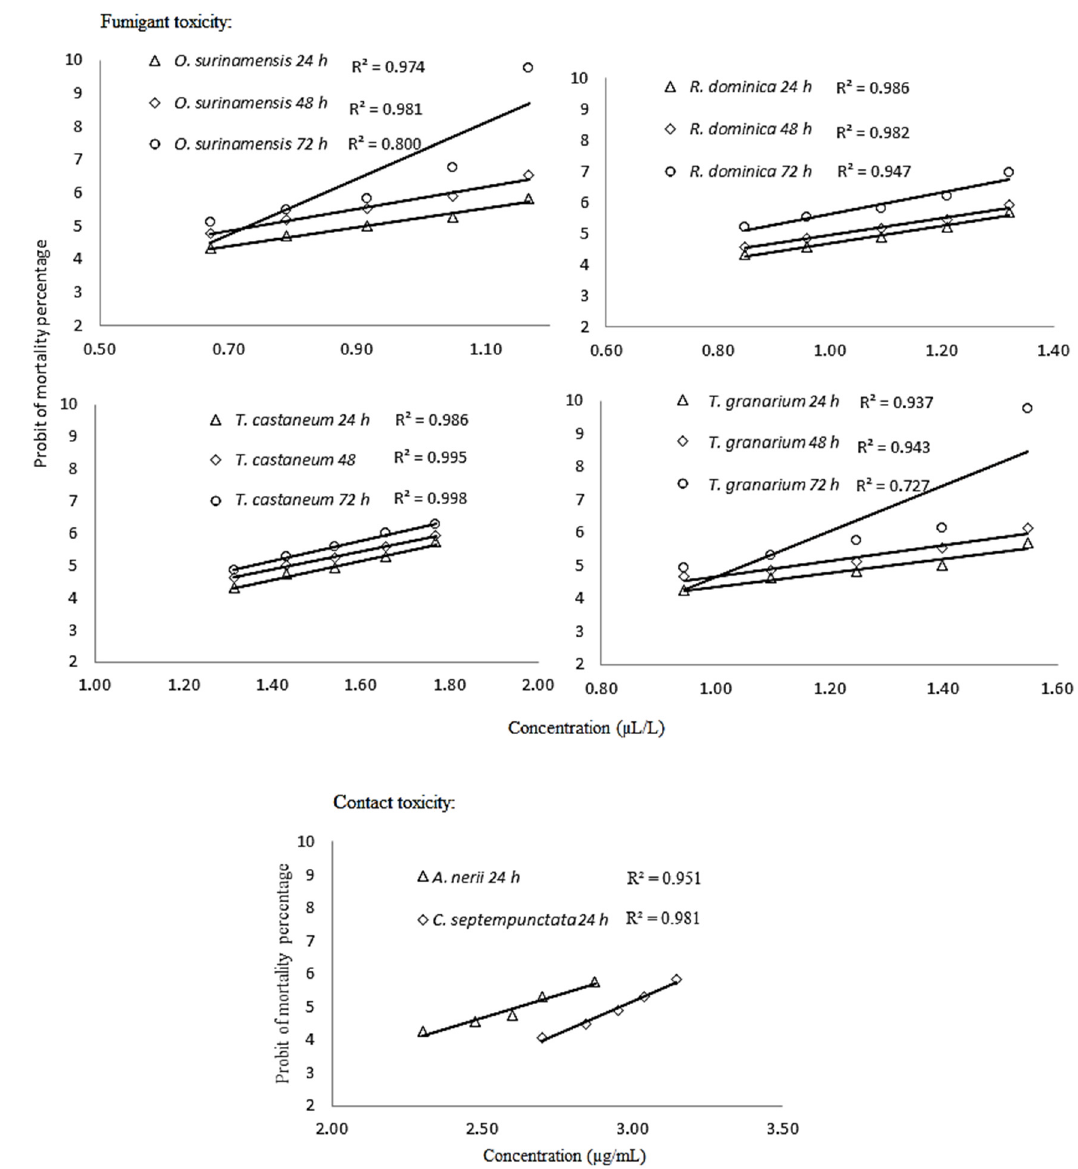
Figure 1. Concentration–response lines of contact and fumigant toxicity of Satureja intermedia essential oil against Aphis nerii and Coccinella septempunctata, and Oryzaephilus surinamensis, Rhyzopertha dominica, Tribolium castaneum, and Trogoderma granarium, respectively.